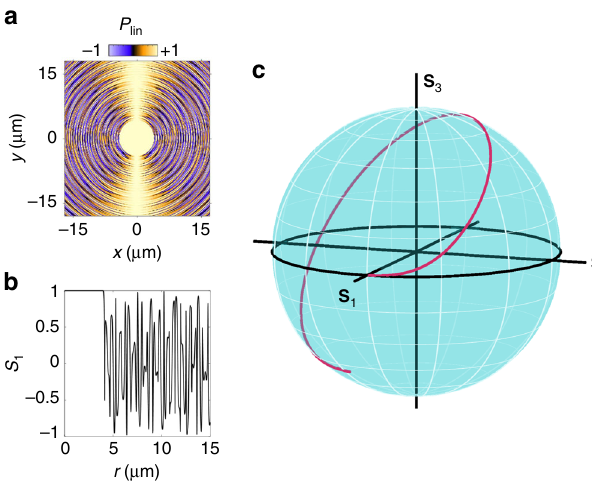
Fig. 5 Simulation of IX polarization state. a Simulated S1 Stokes ’ vector component corresponding to linear polarization of IX emission. Initial conditions at r = r p correspond to linear polarization. Oscillatory S1 behaviour due to coherent spin precession occurs for r > r p . r p = 4 μ m. b Diagonal cross-section of a . c IX polarization state on Poincaré sphere for one fast polarization oscillation cycle in